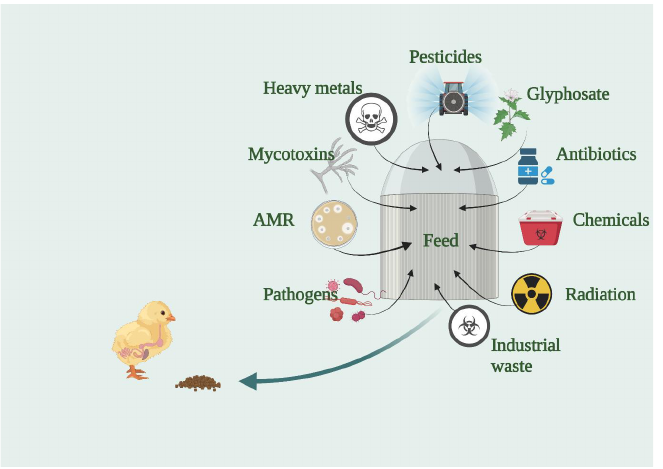
Figure 2. Possible feed contaminants that can disrupt early gut colonisation. Created with BioRen- der. 5. Conclusions Microbial colonisation of the gastrointestinal tract begins as soon as young chicks are hatched and exposed to the external environment. However, in addition to the environ- mental, chemical and biological challenges posed by the modern intensive production system, the first feed offered to chicks already contains its natural microbial community, which could be enriched in pathogens during feed processing and transport. In addition to pathogens, the feed can also carry mycotoxins, heavy metals, pesticides, herbicides and other toxic contaminants. Many of these feed contaminants have aberrant effects on mi- crobiota in adult birds, and those adverse effects would likely amplify in naïve birds. In other cases like radiation, chemical and toxic industrial waste, there was no literature on the effects on poultry intestinal microbiota, but it is safe to presume that they would not be beneficial. The research in early gut colonisation in livestock and poultry is accelerating with the rise of modern high-throughput sequencing and other technologies, and more atten- tion should be given to the precision designing of initial feed. In addition to the conven- tional starter, grower and finisher feed regimen, a carefully designed gut colonisation type of feed that would be offered immediately after arrival to the shed could be beneficial. Considering the speed of the gut colonisation process, it is possible that this could be of- fered only once as the first batch of feed. Enriching this first feed with probiotics and prebiotics could provide lifelong benefits. Different farming practices will complicate at- tempts to standardise new colonisation-targeted practices in poultry farms: time from hatch to placement on the shed floor, time spent in transport, type of transport, etc., vary significantly even between the sheds in the same farm, and more extremely on a global scale. Regardless of the challenges, research in this area to optimise the process will likely benefit bird welfare and productivity.